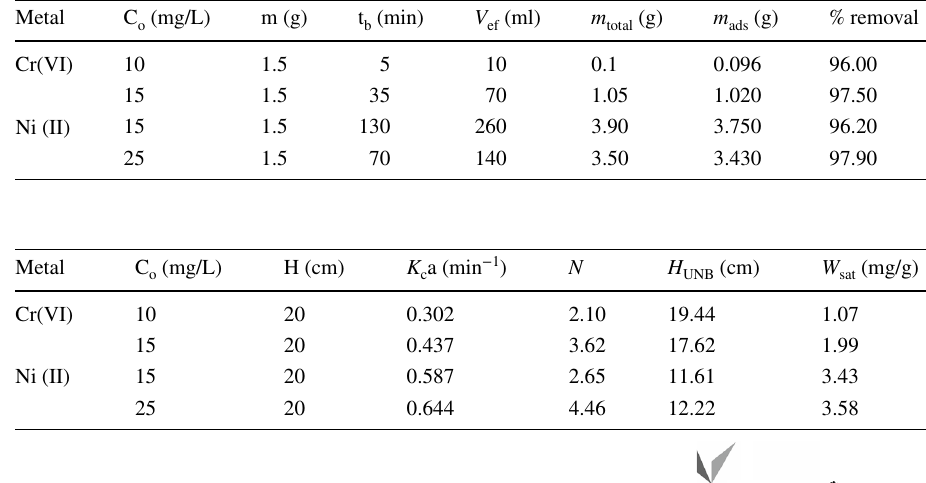
parameters of the removal of Cr (VI) and Ni (II) in fixed bed columns filled with sugarcane bagasse